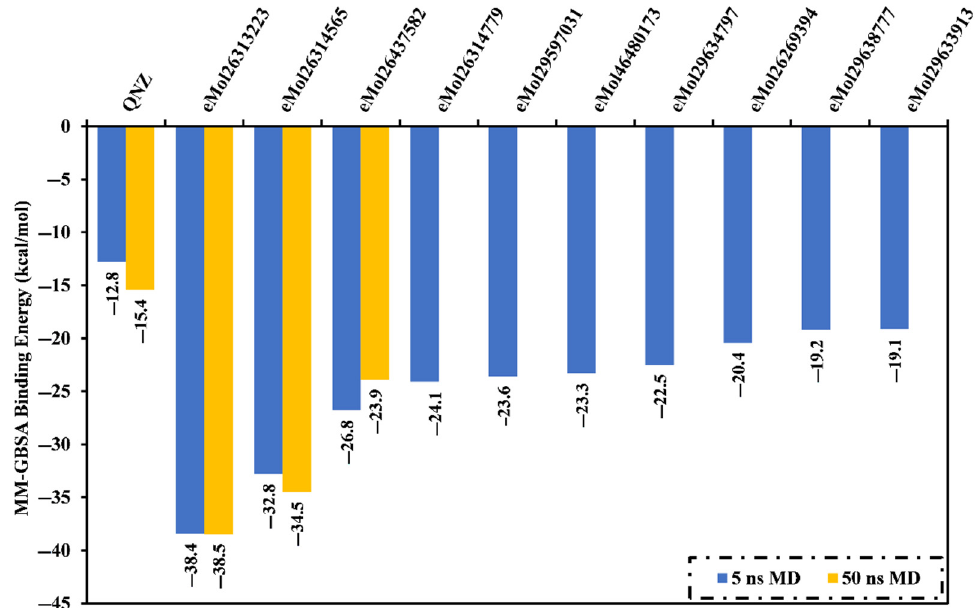
Figure 5. Evaluated MM-GBSA binding energies for the co-crystallized QNZ ligand and the best eight potent inhibitors in complex with mutated PBP2a allosteric site in acidic medium over 5 ns and 50 ns MD simulations.